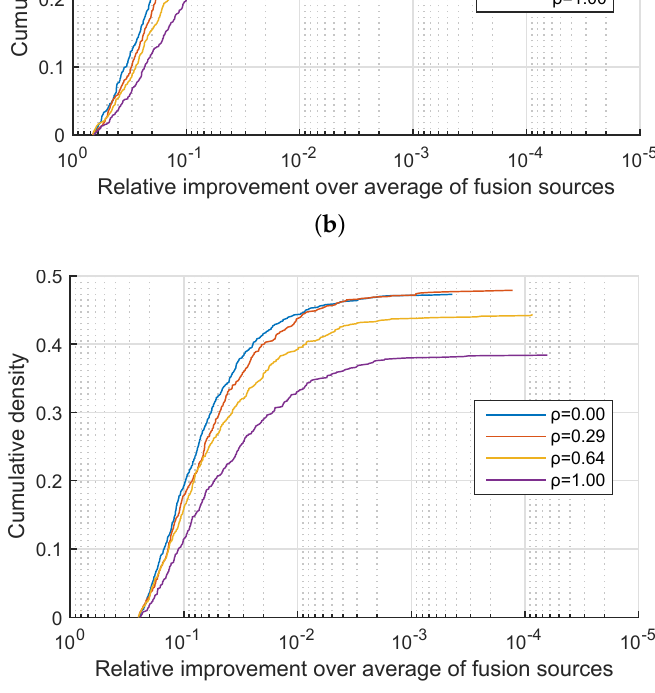
Figure 1. Synthetic data: relative improvement in the confidence of the correct information source identification of the proposed quadratic mean-based fusion over linear fusion, as the corresponding cumulative distribution function. ( a ) β n = 0.05, d = 0.10; ( b ) β n = 0.05, d = 2.28; ( c ) β n = 0.05, d =